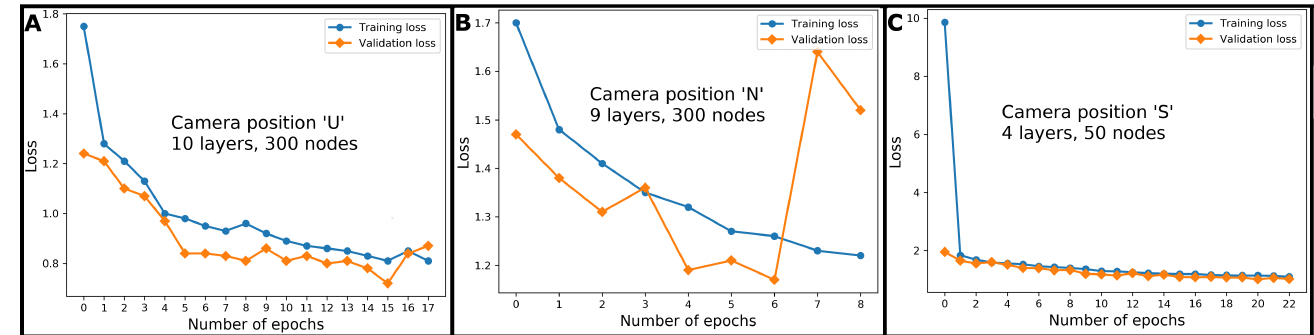
Figure 5. Training and validation loss depending on the number of trained epochs for camera positions ‘U’ (figure part A ), ‘N’ (figure part B ) and ‘S’ (figure part C ).